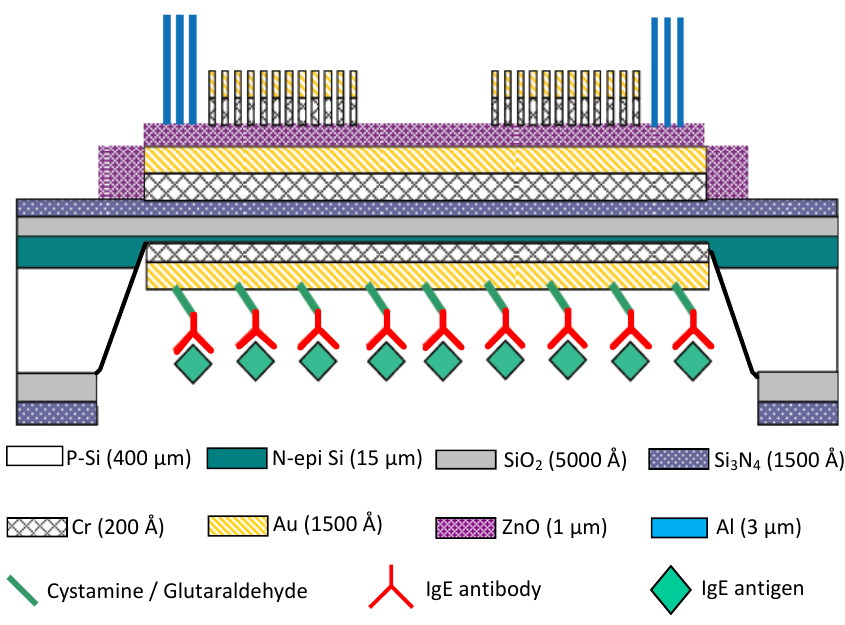
Figure 4. Cross-sectional structure of the FPW-based allergy